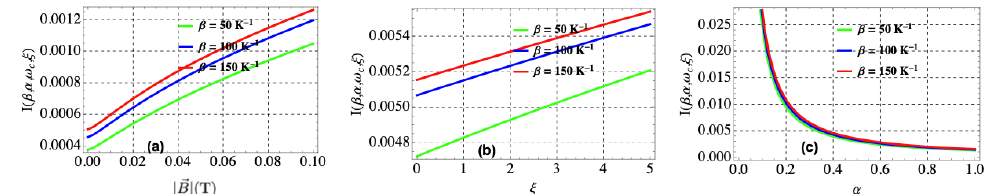
Figure 8. Persistent current I ( β ) as a function of: ( a ) | (cid:126) B | ( T ) for different values of β and the same fixed values as in Figure 1a, ( b ) ξ for different values of β and the same fixed values as in Figure 1b, ( c ) α different values of β and the same fixed values as in Figure 1c. For all three plots, β = 50 k − 1 (green curve), 100 k − 1 (blue curve) and 150 k − 1 (red curve); the maximum vibrational quantum n max and other parameters are same as in Figure